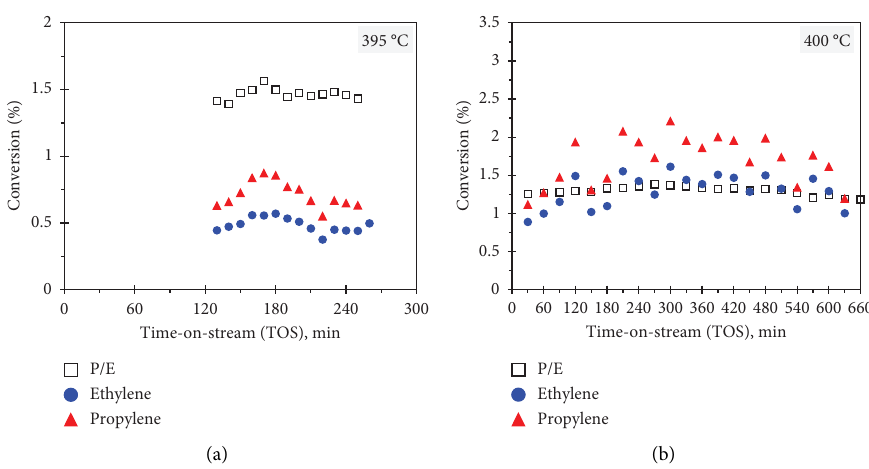
Figure 9: Catalyst performance at two temperatures with time on stream (TOS): LHSV � 1h − 1 ; N